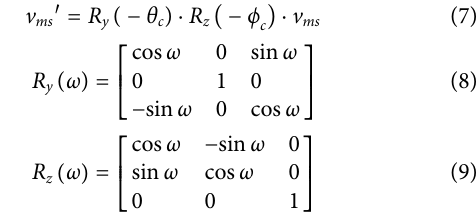
Frontiers in Physics |